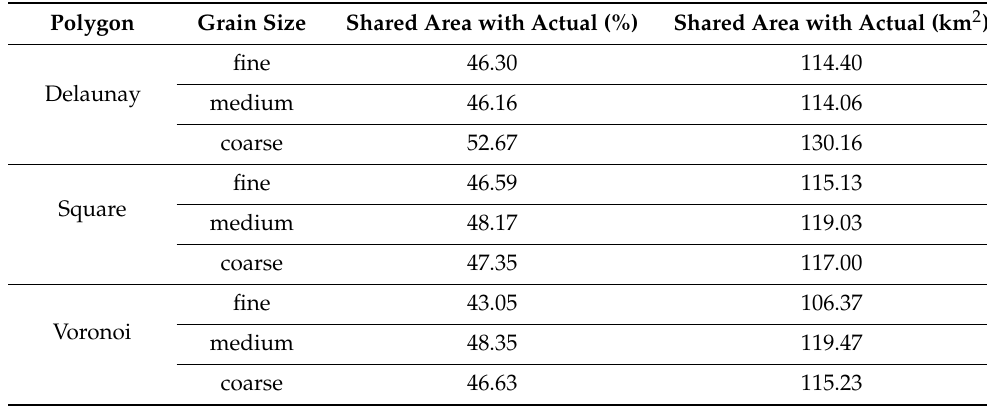
Table 10. Overlapped area (percentage).